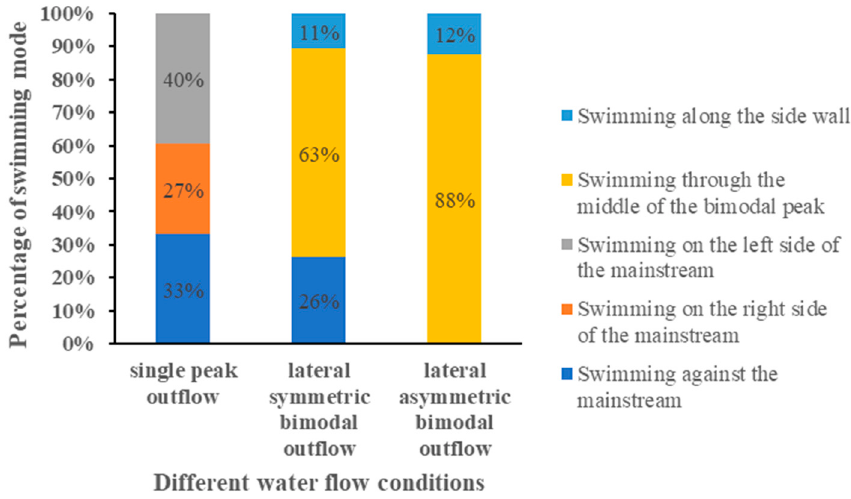
Figure 5. The percentage of swimming mode under different water flow conditions.